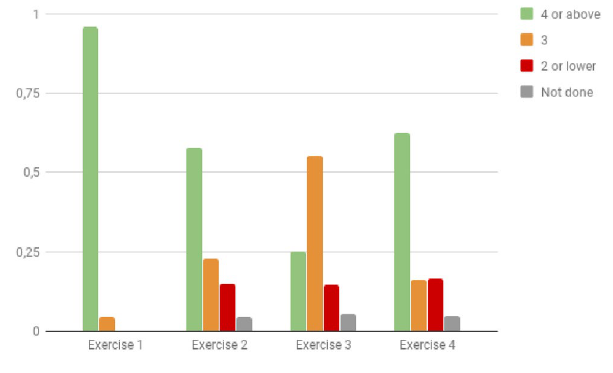
Fig. 8 Results obtained for variant 1—workout video. In graphs a, b the blue bars represent the average score obtained for the cor- responding item, with the black arrows representing the ±sigma